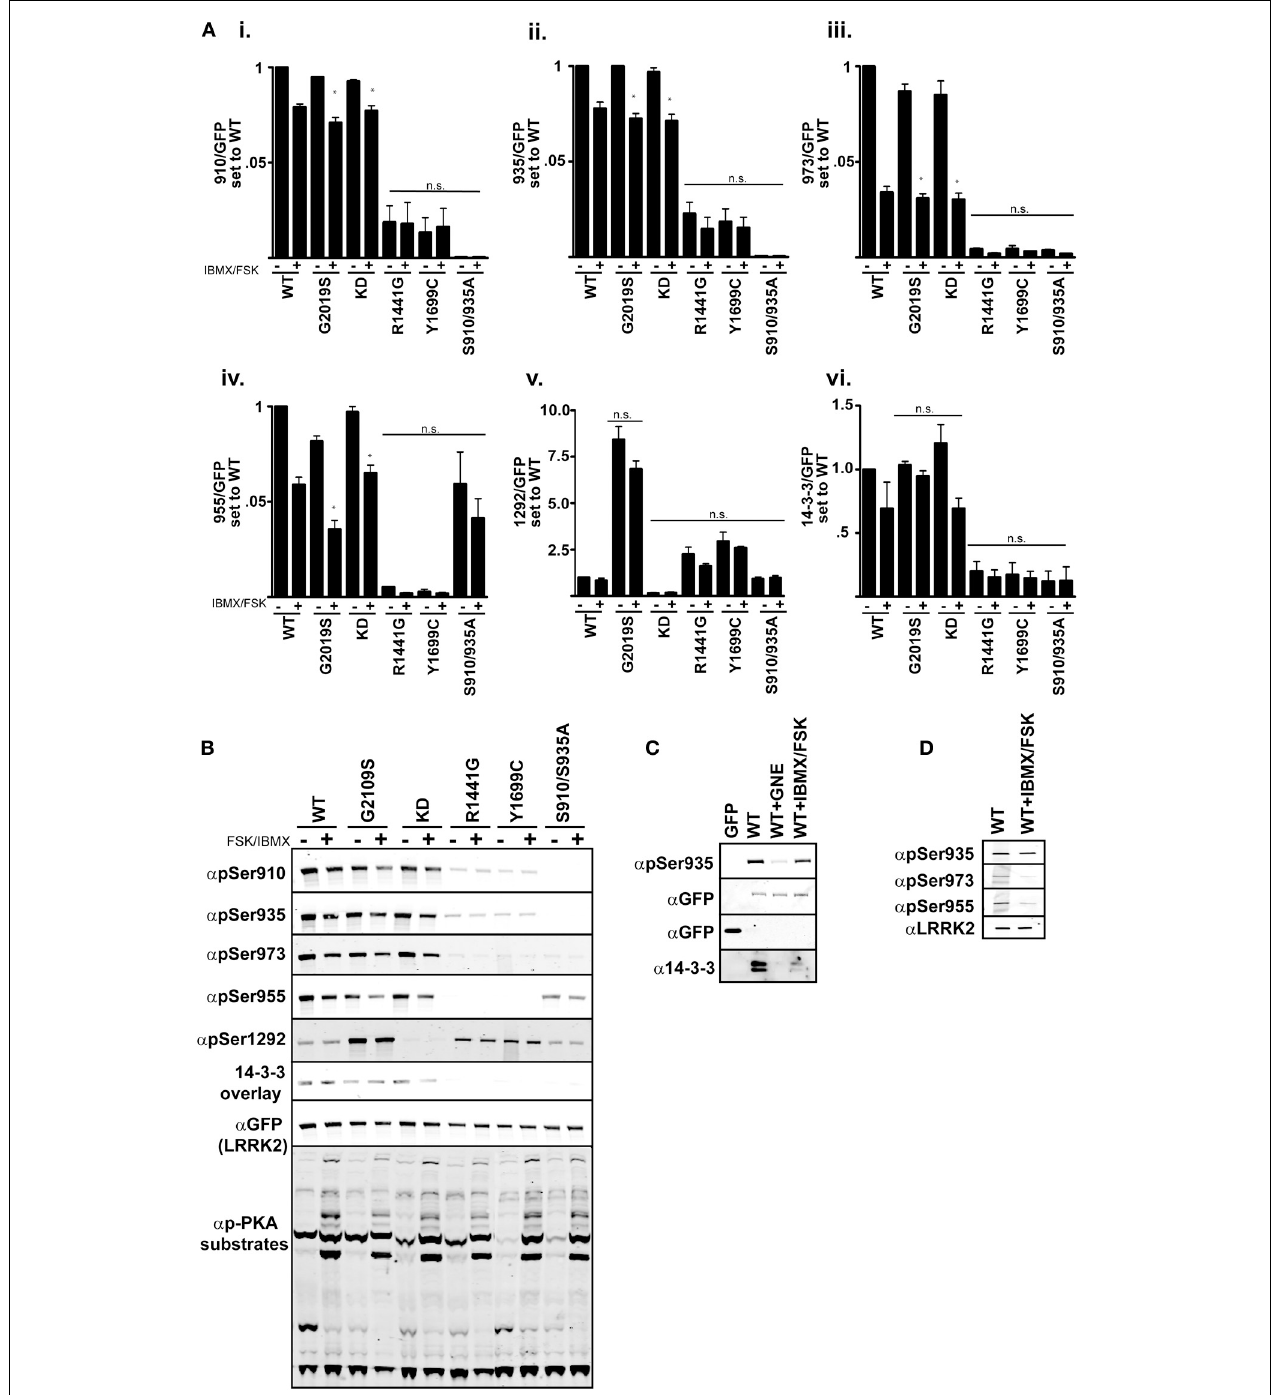
FIGURE 4 | cAMP stimulation does not increase 14-3-3 binding in HEK 293 cells. (Ai–vi) Quantification of the phosphorylation levels at the cellular sites (935, 955, 973), autophosphorylation site 1292, and 14-3-3 binding in IBMX/FSK treatment relative to the DMSO treated control from (B) . (B) Representative blots of cellular site phosphorylation levels and autophosphorylation at Ser1292 in the indicated GFP-LRRK2 mutants after 30min treatment with 50 μ M FSK/100 μ M IBMX. Stimulation of PKA activity